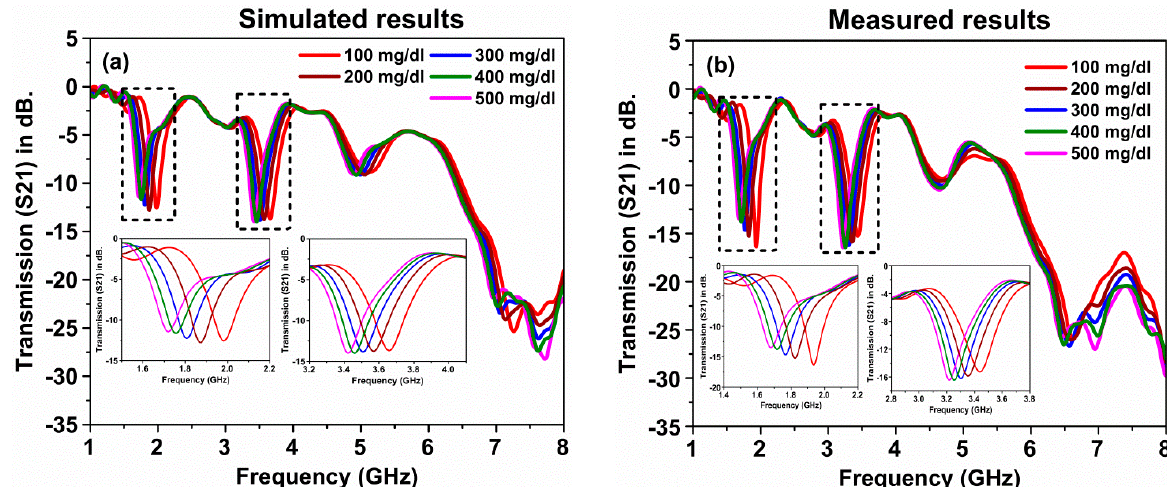
Figure 12. A comparison of the glucose–blood mixture sample of the proposed metamaterials sensor: ( a ) simulated and ( b ) measured.